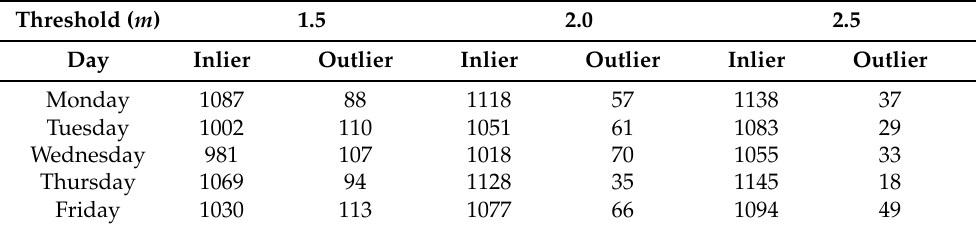
Table 5. Application of the TEDA algorithm by varying the threshold ( m ): 1.5, 2.0, and 2.5.